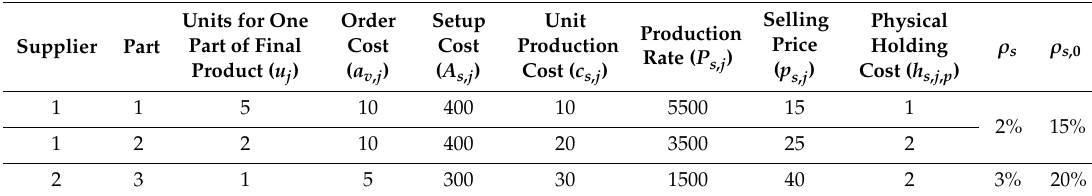
Table 1. Input data.